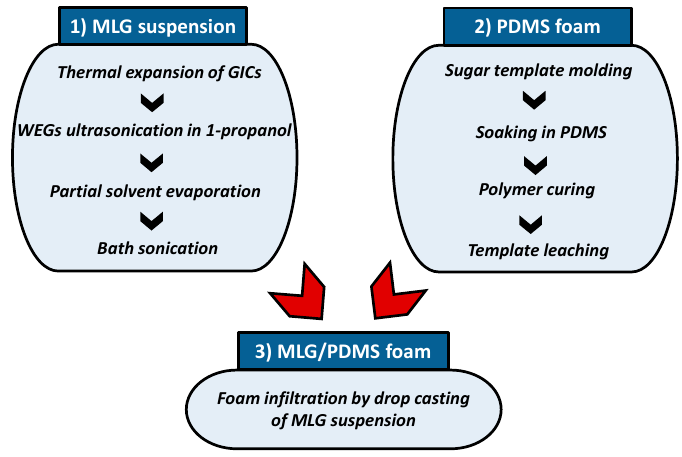
Figure 1. The main steps to obtain piezoresistive MLG/PDMS foams.